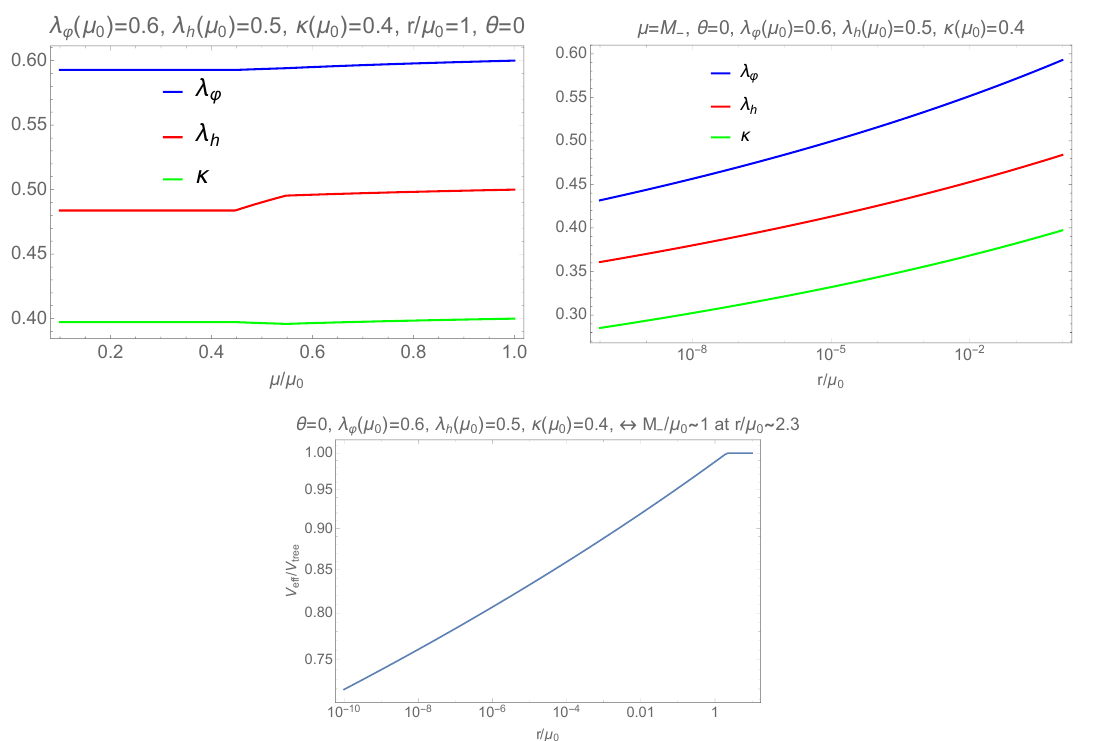
; M ) = M . Lower: + (cid:0) (cid:0) . We can see the step behaviors, 0